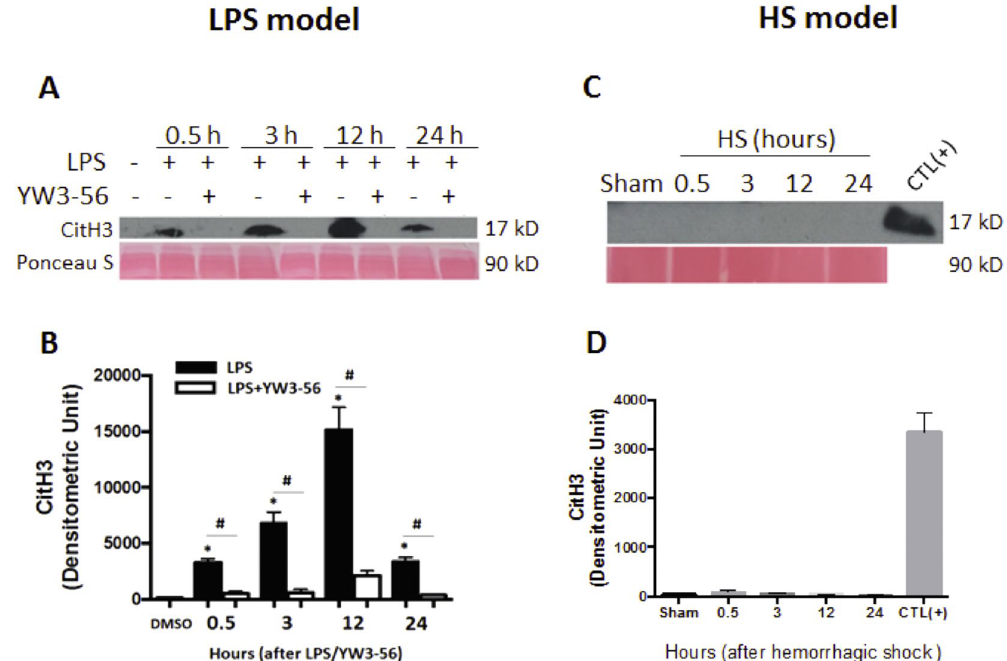
Figure 2. Effect of different treatments (LPS, LPS + YW3-56, or HS) on blood levels of CitH3 in mouse models of LPSS and HS. Mice were intraperitoneally injected with LPS (35 mg/kg) in presence or absence of YW3-56 ( A ) or received hemorrhage (30% blood loss) ( C ). Animals from Sham group received all procedures except cannulation and hemorrhage. Blood was harvested at 0.5, 3, 12 and 24 hours after treatments. Circulating CitH3 was detected by Western blotting. Ponceau S stain was performed as loading control. Densitometry units were measured by Image J ( B and D ). Serum from LPS treated mice (35 mg/kg, 12 hours post LPS) served as positive control (CTL) ( C ). Data are shown as mean ± SD, n = 3/group. CitH3: Citrullinated histone H3; LPS: Lipopolysaccharide; HS: Hemorrhagic shock; DMSO: dimethyl